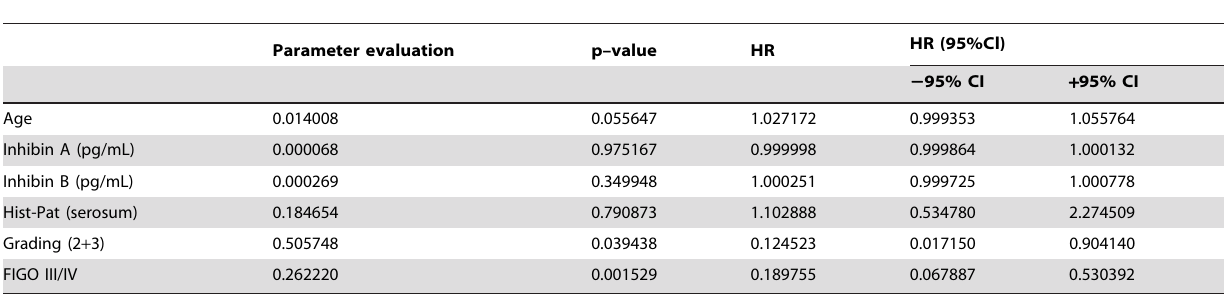
Table 6. Prognostic factors for overall survival selected by Cox’s univariate analysis.